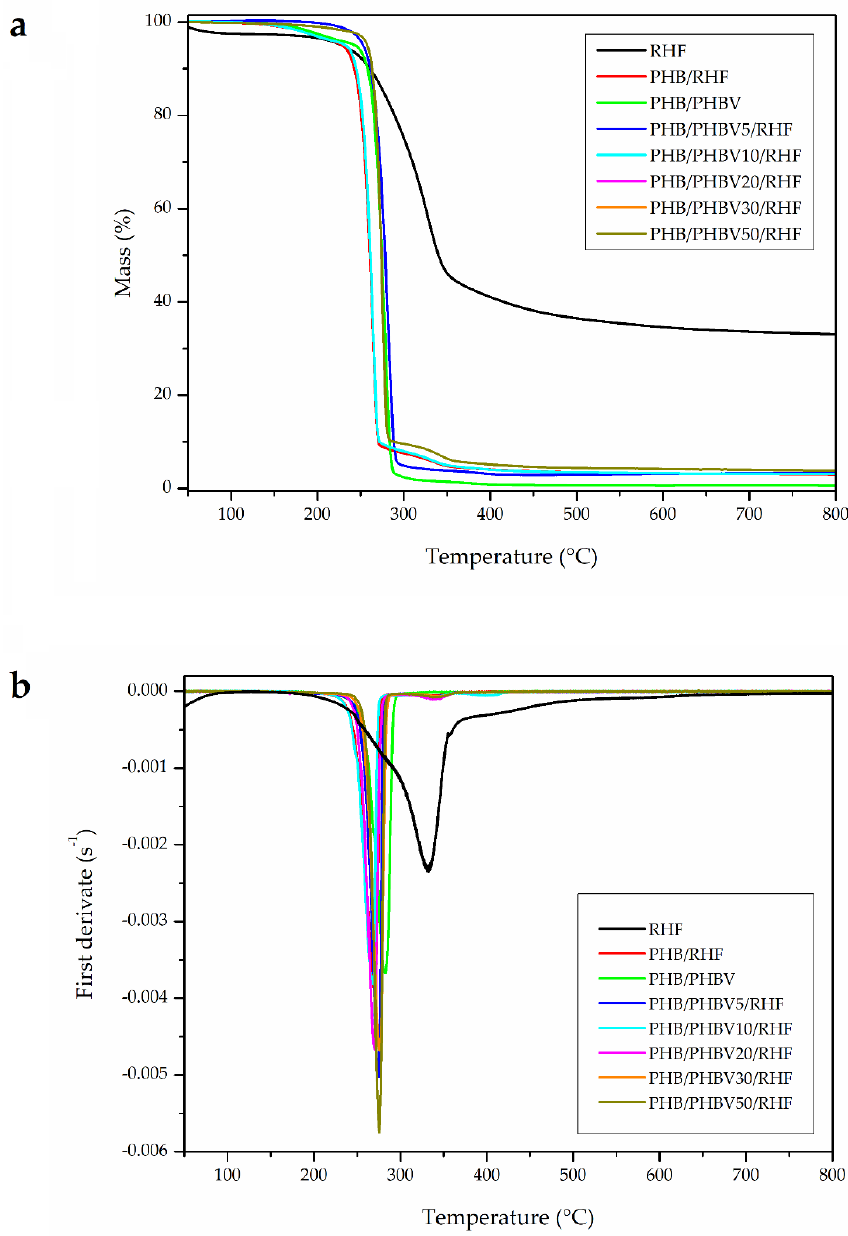
Figure 6. ( a ) Thermogravimetric analysis (TGA) and ( b ) first derivative (DTG) curves of the thermo-compressed films made of poly(3-hydroxybutyrate) (PHB), poly(3-hydroxybutyrate- co -3-hydroxyvalerate) (PHBV), and rice husk flour (RHF).